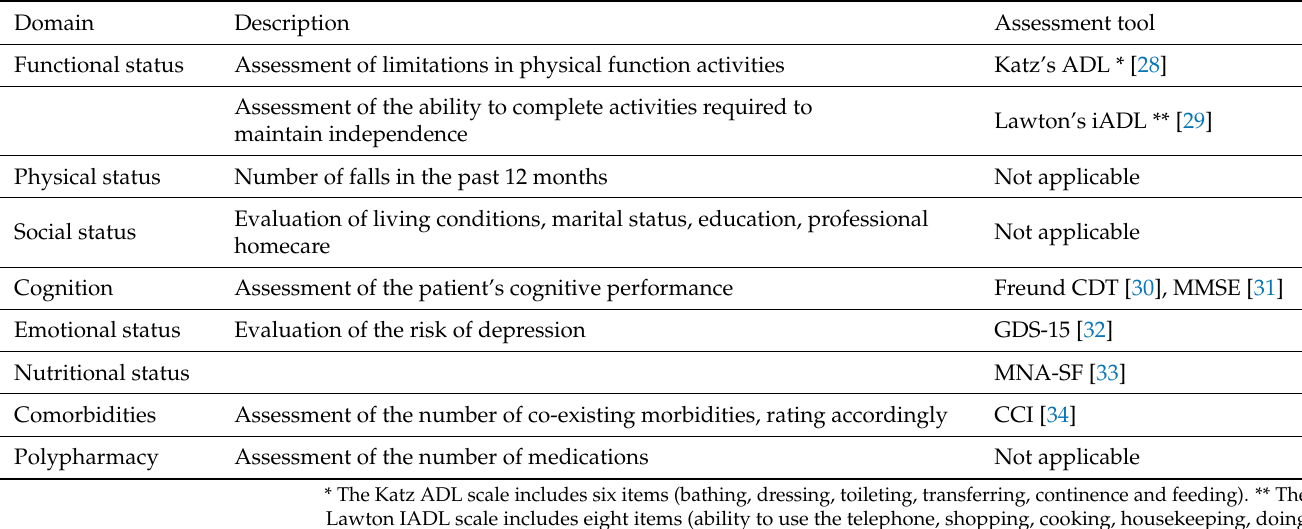
Table A1. Content of the comprehensive geriatric assessment (CGA).